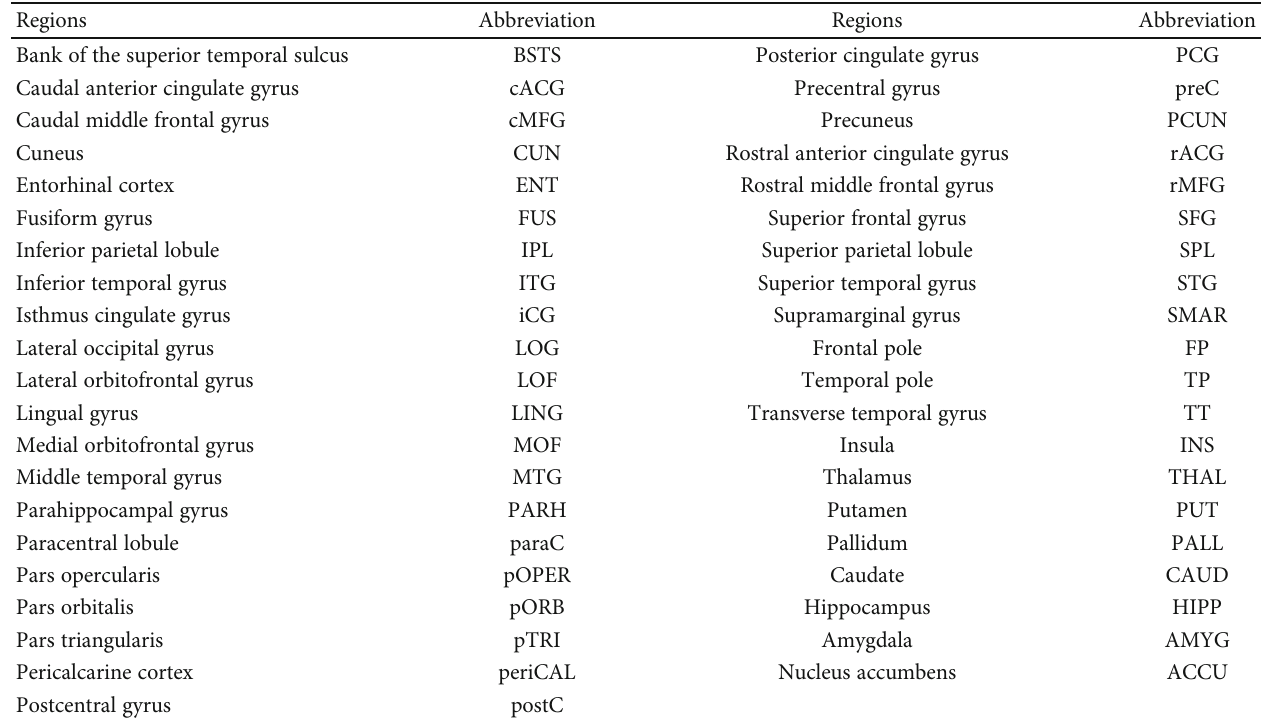
Table 1: Cortical and subcortical regions of interest de fi ned in this